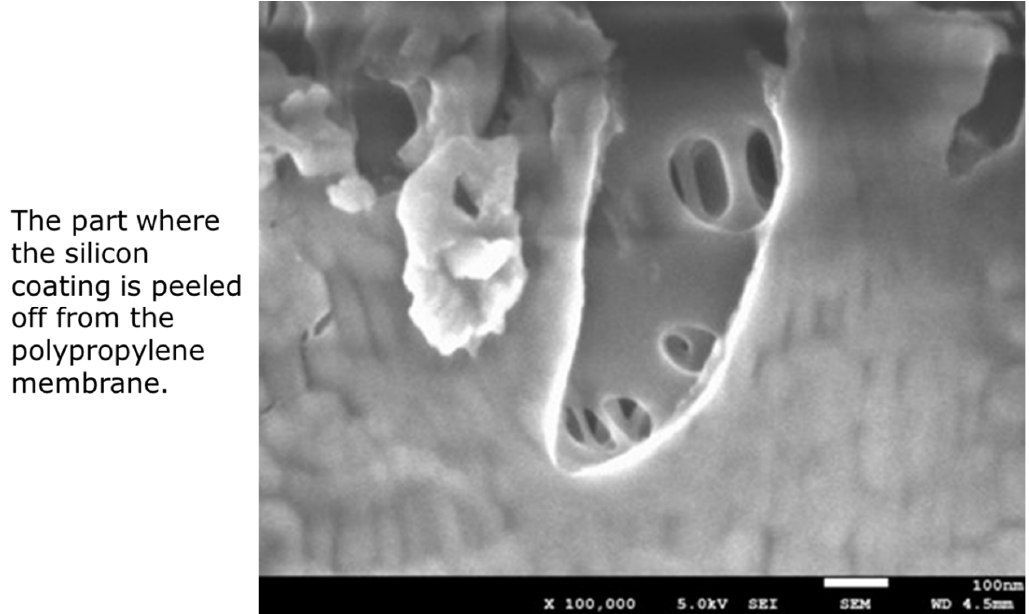
Figure 5. FE-SEM image of MERA NHP ® (dry), the outer surface of the capillary membranes; and ×100,000. Figure 6 is FE-SEM images of BIOCUBE ® (dry), (a) the surface of inner lumen of the capillary membranes and (b) the outer surface of the capillary membranes. Sample C is a PMP membrane, and the unique pore structure is different from Fig- ures 3 and 4. The inner surface of the membrane has the unique mountain-range structure that includes pores. The outer surface of the membrane is highly porous compared to the inner surface of the membrane. The three-dimensional unevenness of the outer surface of the membrane is considerably larger than the inner surface, but in principle for the FE- SEM, it is difficult to obtain three-dimensional information using the FE-SEM.